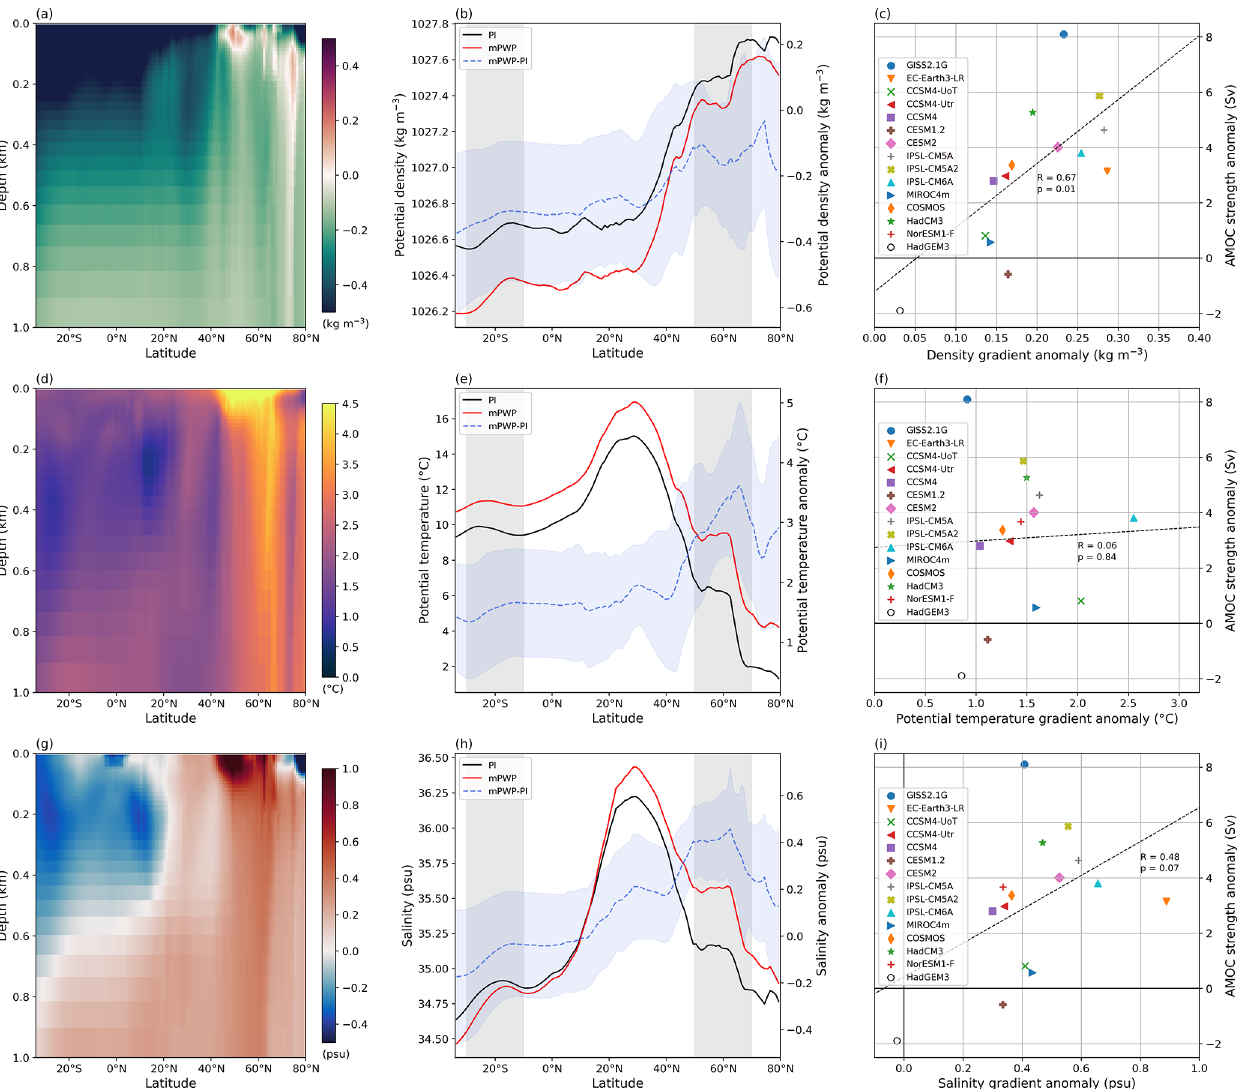
Figure 4. (a) MMM top 1km Atlantic zonal-mean potential density mPWP–PI anomaly. (b) MMM top 1km depth-averaged Atlantic zonal- mean potential density in the PI and mPWP (left y axis) and mPWP–PI anomaly (right y axis). Blue shading indicates 1 standard deviation from the MMM by individual models. (c) Individual model mPWP–PI AMOC strength anomaly plotted against the mPWP–PI anomaly in meridional gradient of the top 1km Atlantic potential density. The meridional gradient is defined as the difference between the 50–70 ◦ N average and 10–30 ◦ S average (latitude bands are indicated by gray shading in (b) . (d–f) Same as (a–c) for potential temperature. (g–i) Same as (a–c) for